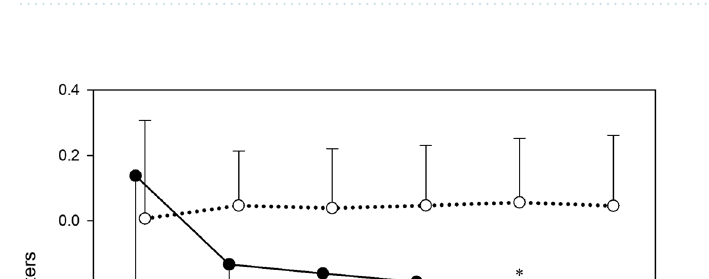
Table 1. Patients’ demographic. Mean ± standard deviation (range).